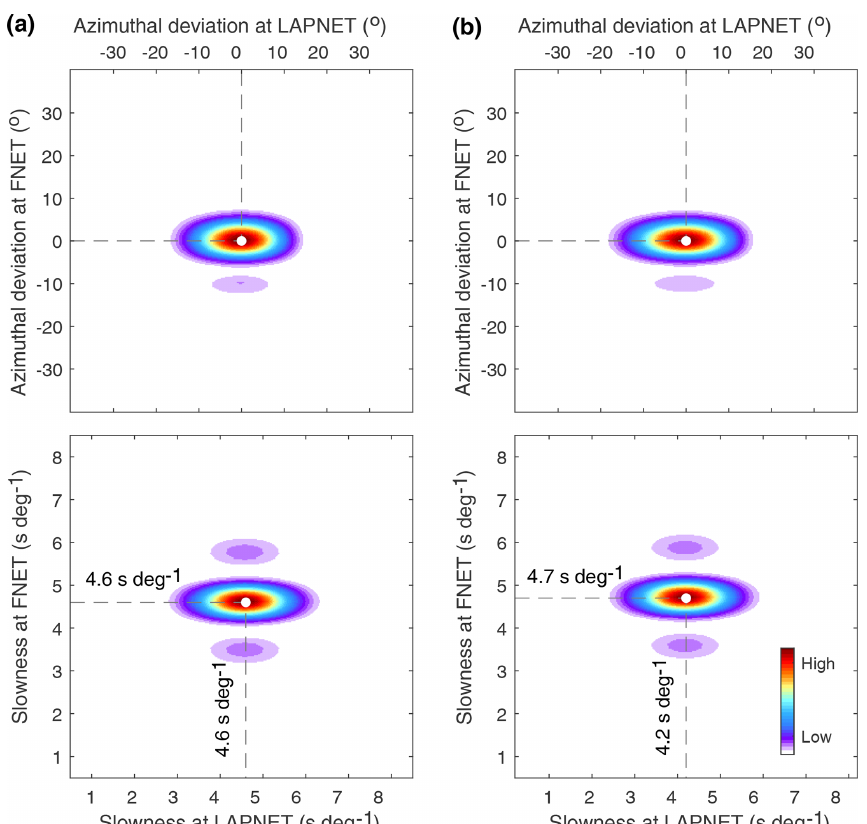
Figure 6. Numerical tests for the double-array slowness analysis of the FNET–LAPNET correlations at a seismic period of 6.2s. The input azimuths of the interfering waves are confined to the great circle crossing FNET and LAPNET. The azimuthal deviation refers to the clockwise azimuthal deviation of slowness from the great circle. The input slownesses of the interfering waves are (a) 4.6s per degree at both LAPNET and FNET and (b) 4.2s per degree at LAPNET and 4.7s per degree at FNET, which are well resolved by the slowness